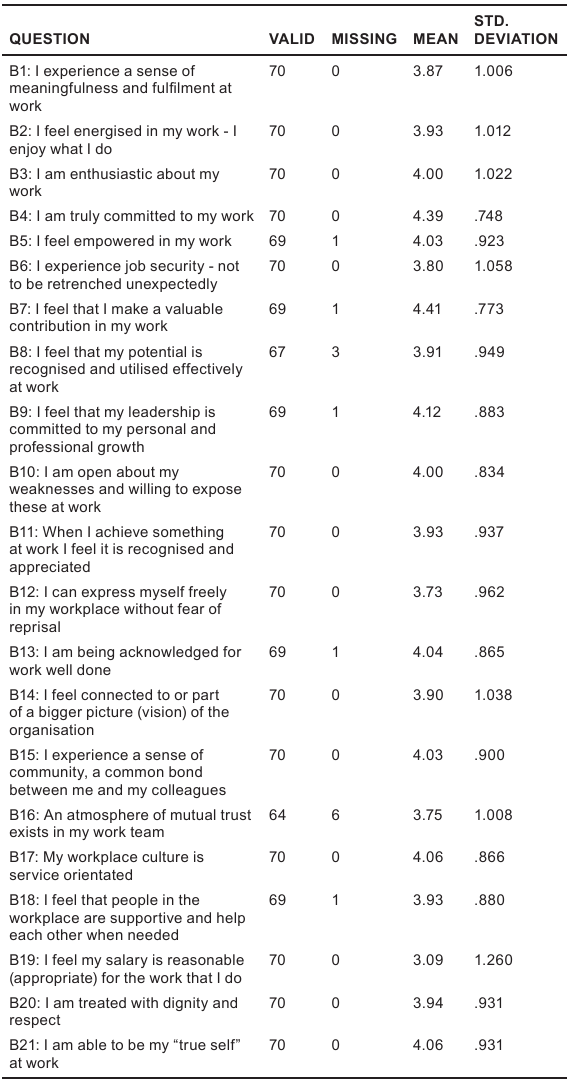
TABLE 12 Statistics of Questionnaire